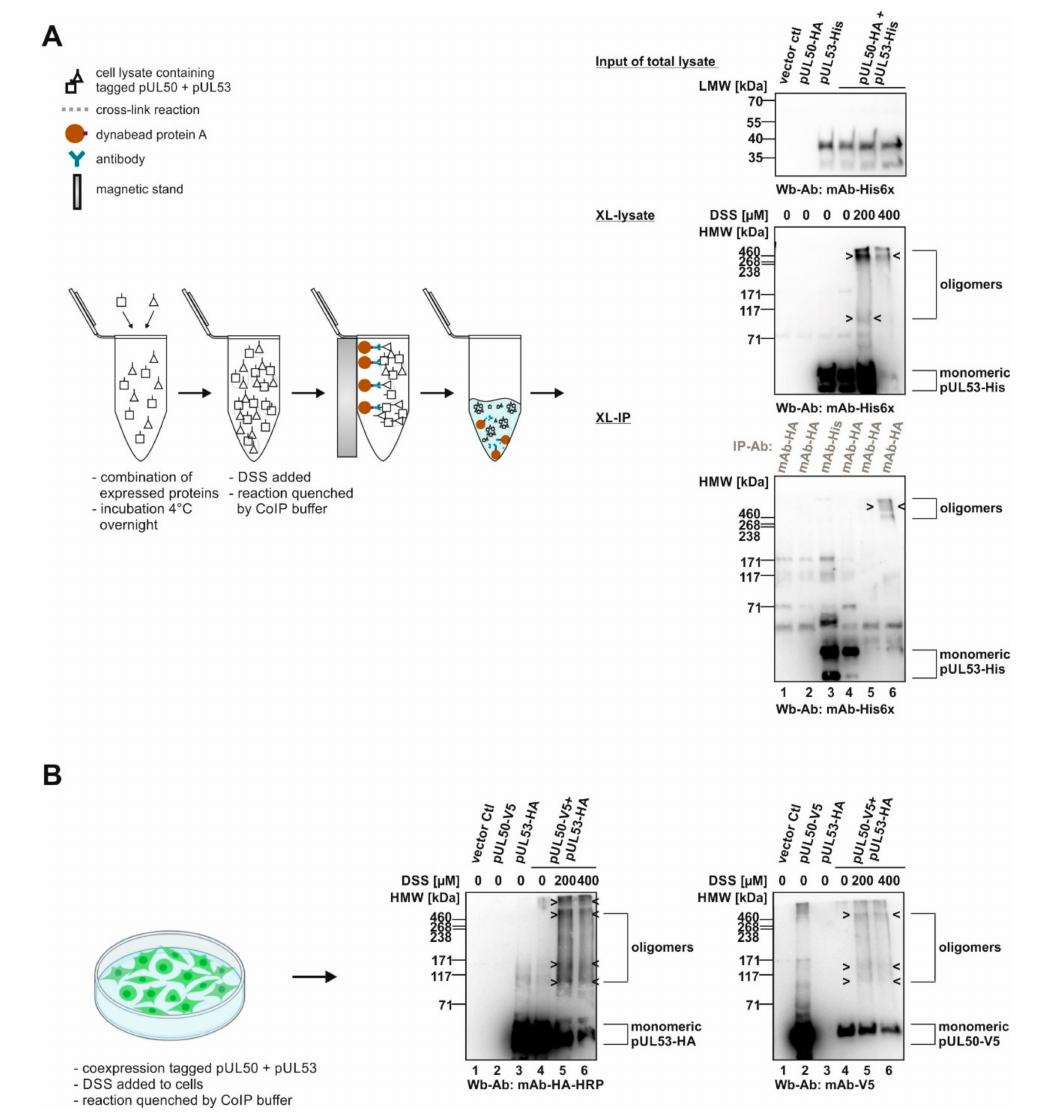
Figure 1. Schematic depiction of the cross-linking approach (XL) using transiently expressed proteins: signals of core NEC protein oligomerization. ( A ) In vitro NEC assembly assay for chemical cross- linking (XL-IP): the single transient expression of tagged pUL50 and pUL53 were assembled and DSS was utilized to stabilize protein–protein interactions by covalent conjugation. Oligomer formation was demonstrated by immunoprecipitation and Wb detection was achieved using tag-specific antibodies. ( B ) Intracellular approach of chemical cross-linking (XL): core NEC oligomers can be directly detected via cross-linking the coexpressed tagged pUL50 and pUL53 from total lysates of 293T cells using Wb analysis. HMW/LMW, high/low molecular weight